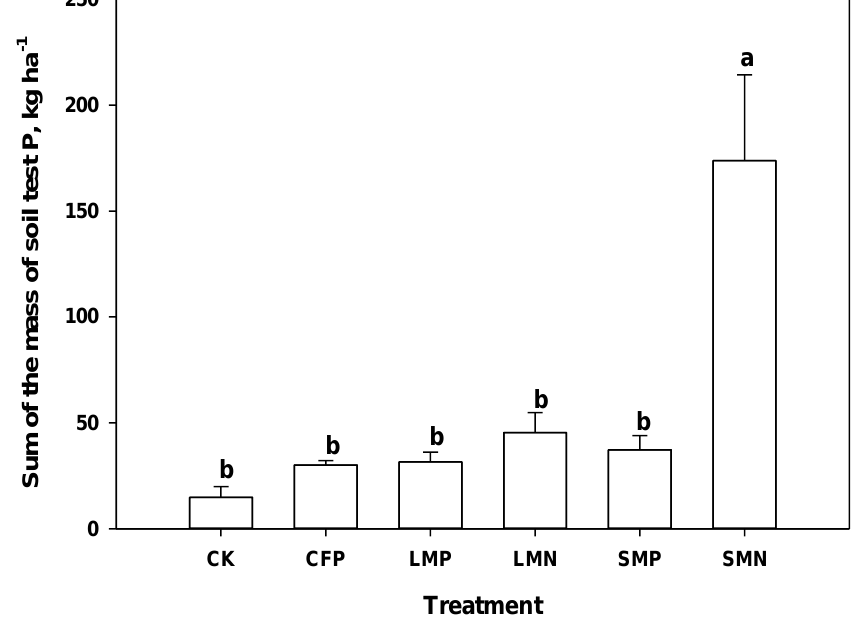
Figure 7. Effects of various sources of P addition (chemical fertilizer vs. liquid and solid swine manures) and application approaches (P-based vs. N-based) on the sum of mass of STP (Olsen-P) in top 30 cm plot soil (SMS 0–30 cm) after 10-year corn-soybean production in a clay loam soil, Woodslee, ON, Canada. Horizontal bars are standard errors ( n = 3), the letters over the bars indicate differences at the significant level of p ≤ 0.05.